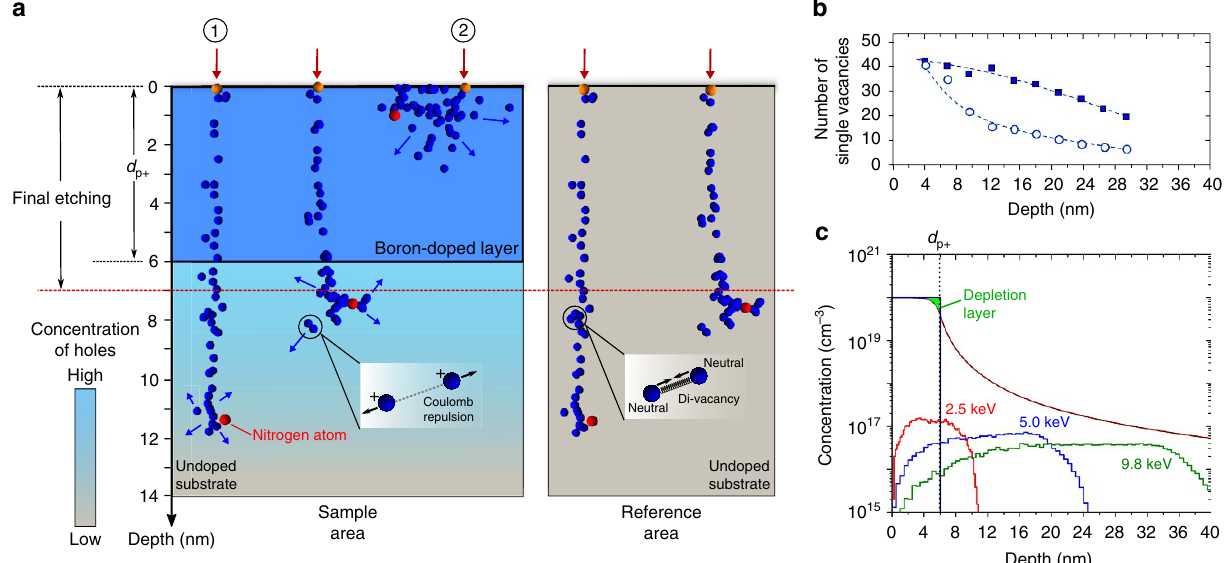
Figure 1 | Simulated implantation defects in diamond and the proposed p þ –i structure. ( a ) Individual implantation sites (indicated by red arrows) simulated by MD with 4.0keV nitrogen kinetic energy are shown representing different contributions of ion channelling. Blue dots represent implantation- induced vacancies, whereas red dots represent the rest position of implanted nitrogen atoms. A schematic representation of the novel method of nitrogen implantation across a planar p þ –i junction is shown with the corresponding experimental steps (see left): boron-doped surface layer (6nm) produced by CVD overgrowth, nitrogen implantation followed by thermal annealing and the final plasma etching step to remove the sacrificial boron-doped layer (7nm)—the final fabricated region is named as ‘Sample area’ in the main text. The concentration of free charge carriers (holes) in the substrate is represented by the blue–grey colour scale. The reference area is also shown, where vacancies are found mainly in the neutral charge state. ( b ) Depth dependency of single vacancies counted at each implantation site (squares) or confined in defect clusters of nanometre radius (see Supplementary Note 1) around nitrogen atoms at rest (circles) extracted from the MD simulations. ( c ) 1D depth profile of boron acceptors (blue-solid line) and free holes (dark red-solid line) across the p þ –i junction structure at 950 (cid:2) C by numerical simulation. Profiles of implanted nitrogen atoms for three different energies (2.5, 5.0 and 9.8keV) simulated by CTRIM are shown for 3 (cid:2) -off implantation angle in a [100]-oriented diamond lattice (ion fluences of 10 11 cm (cid:2) 2